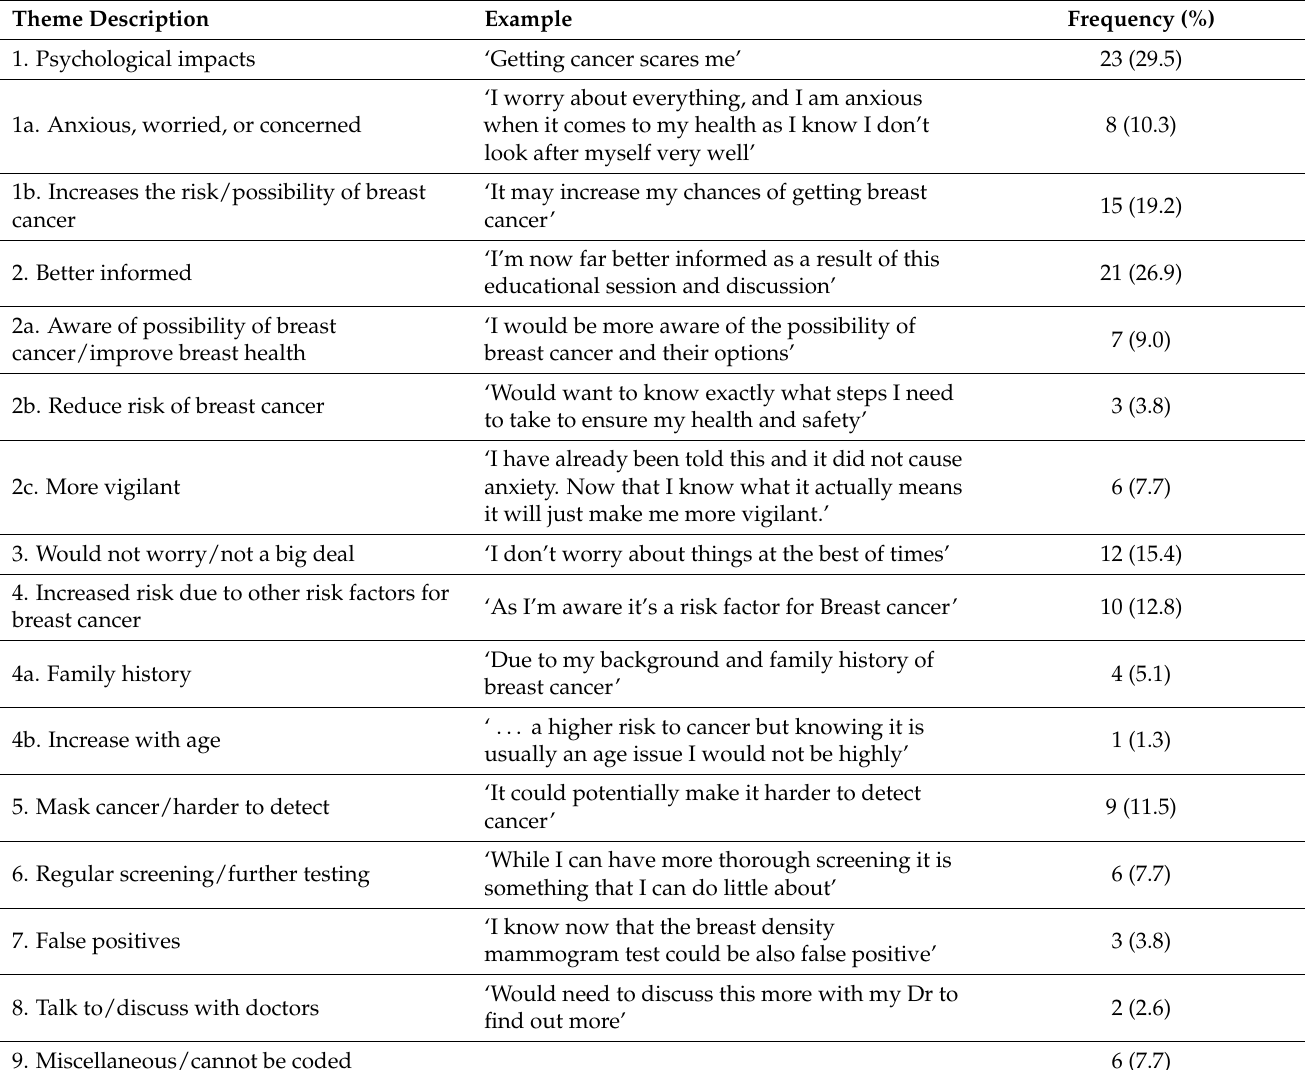
Table 2. Main themes and sub-themes surrounding the topic of anxiety related to information about dense breasts with quotations and frequencies ( n = 78)